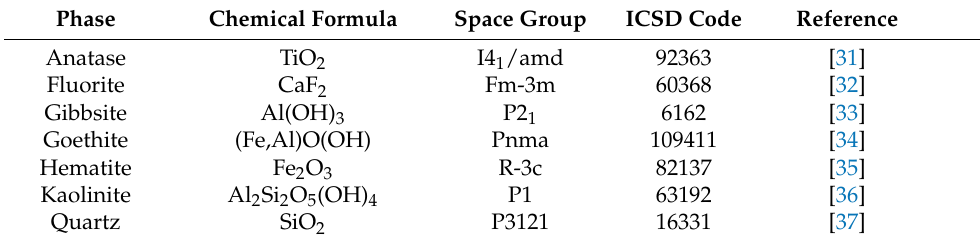
Table 1. Phases and their respective ICSD codes used in the Rietveld refinements. Phase Chemical